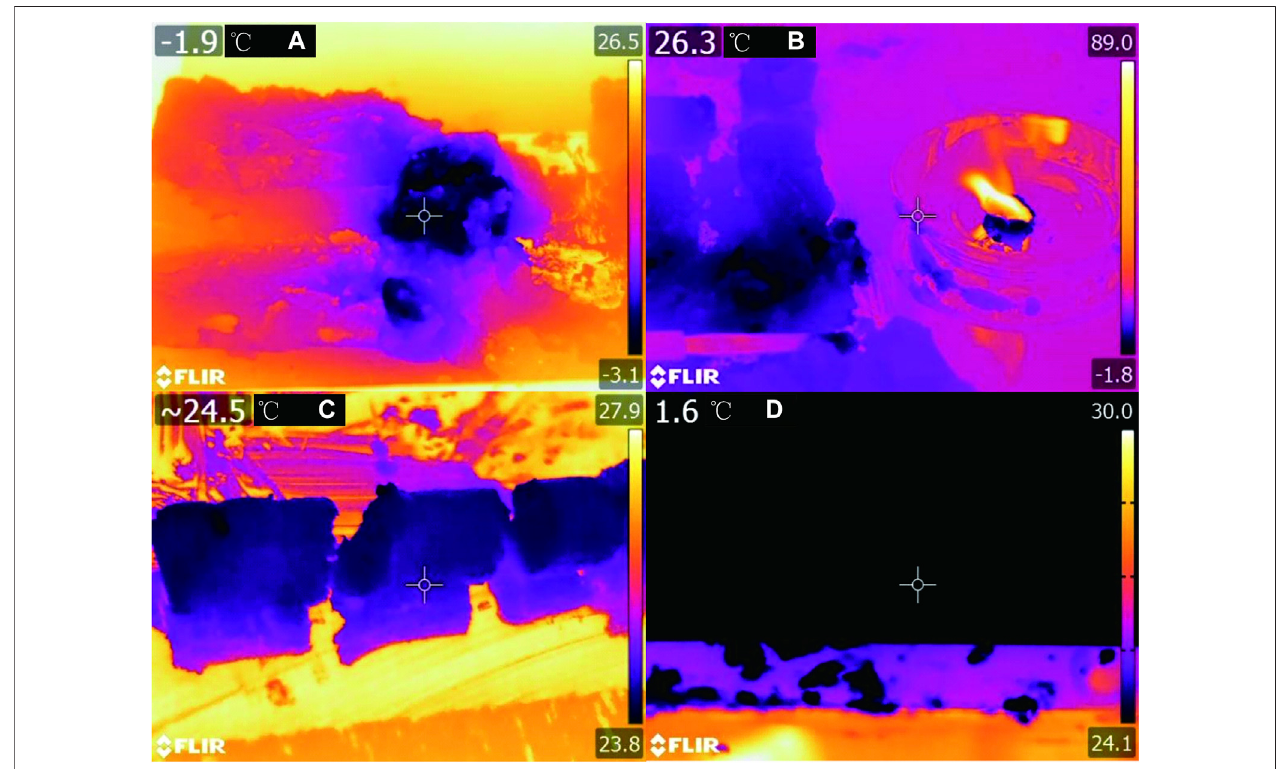
FIGURE 4 | Core thermal imaging characteristics (A) hydrate measurement; (B) fl ame measurement; (C) Columnar core measurement; (D) ore body measurement).